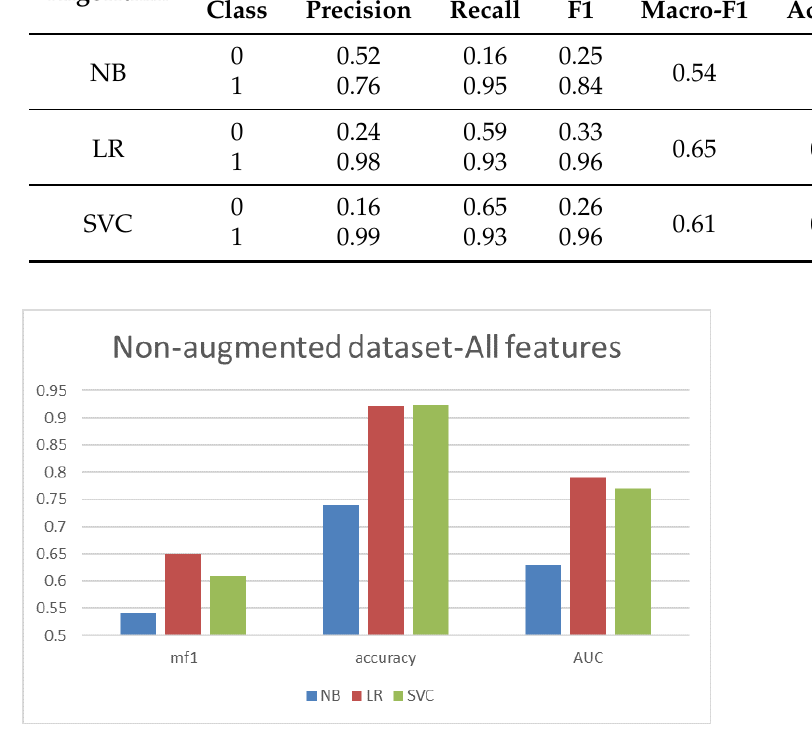
Figure 5. Plot of the non-augmented dataset with all feature results (Experiment